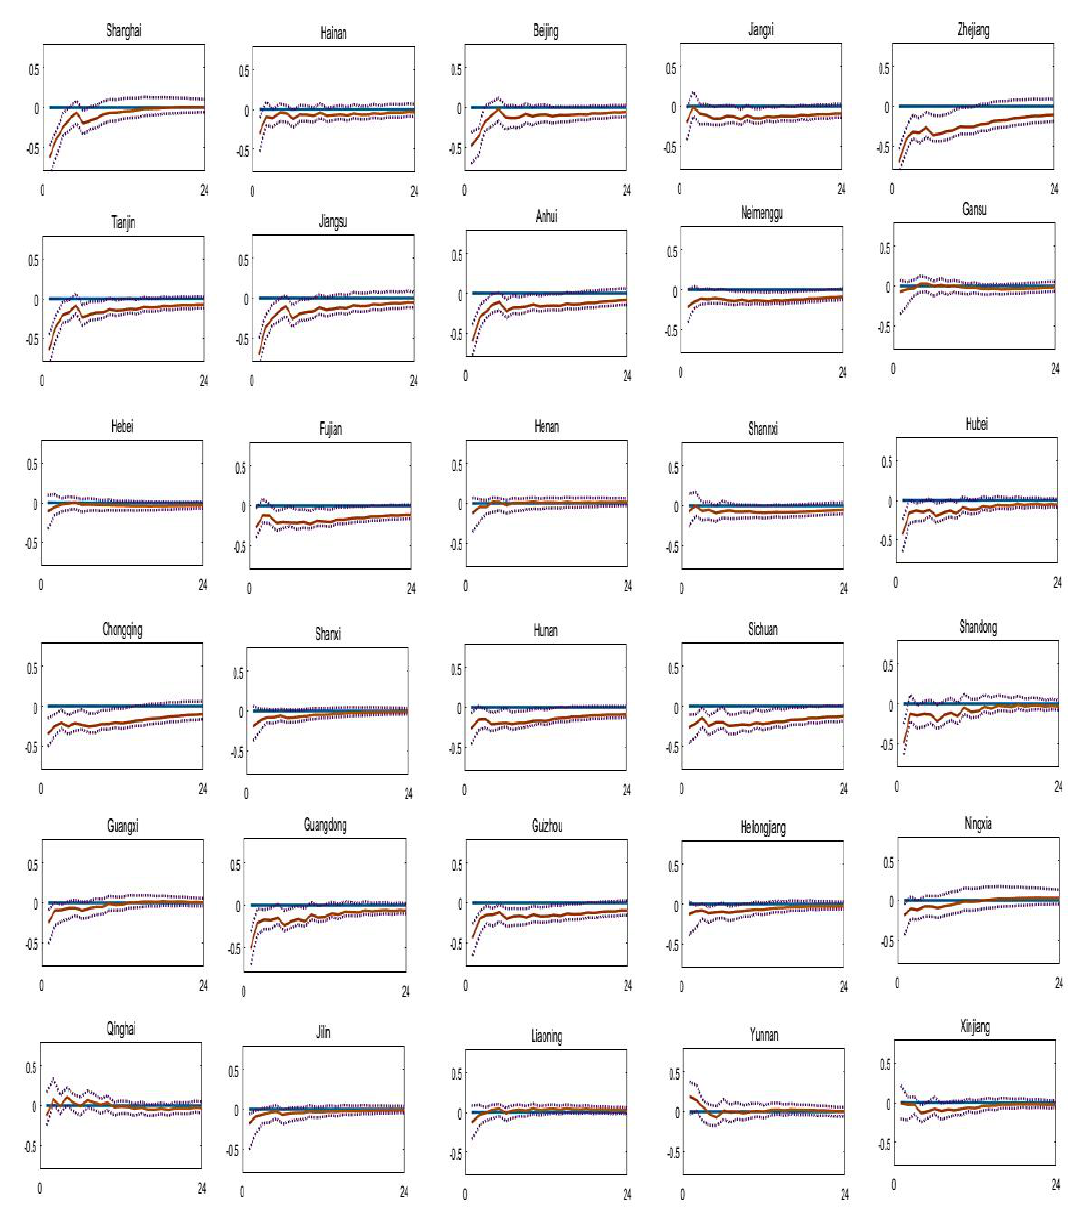
Figure A1. Impulse responses of regional house prices to one standard error shock to interest rate: FAVAR system with three factors.